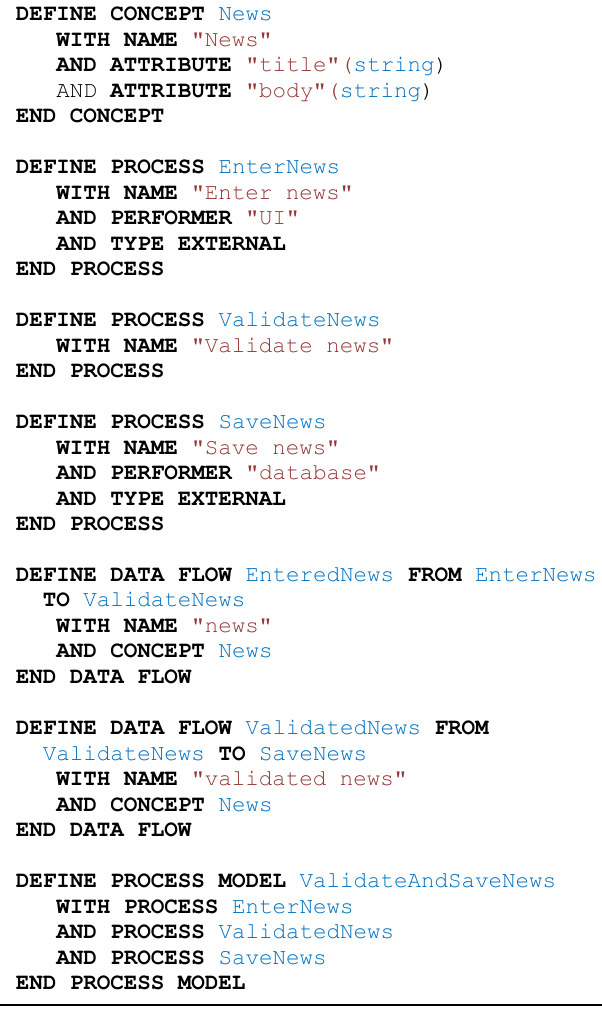
Fig. 10. DSL definition of the sample